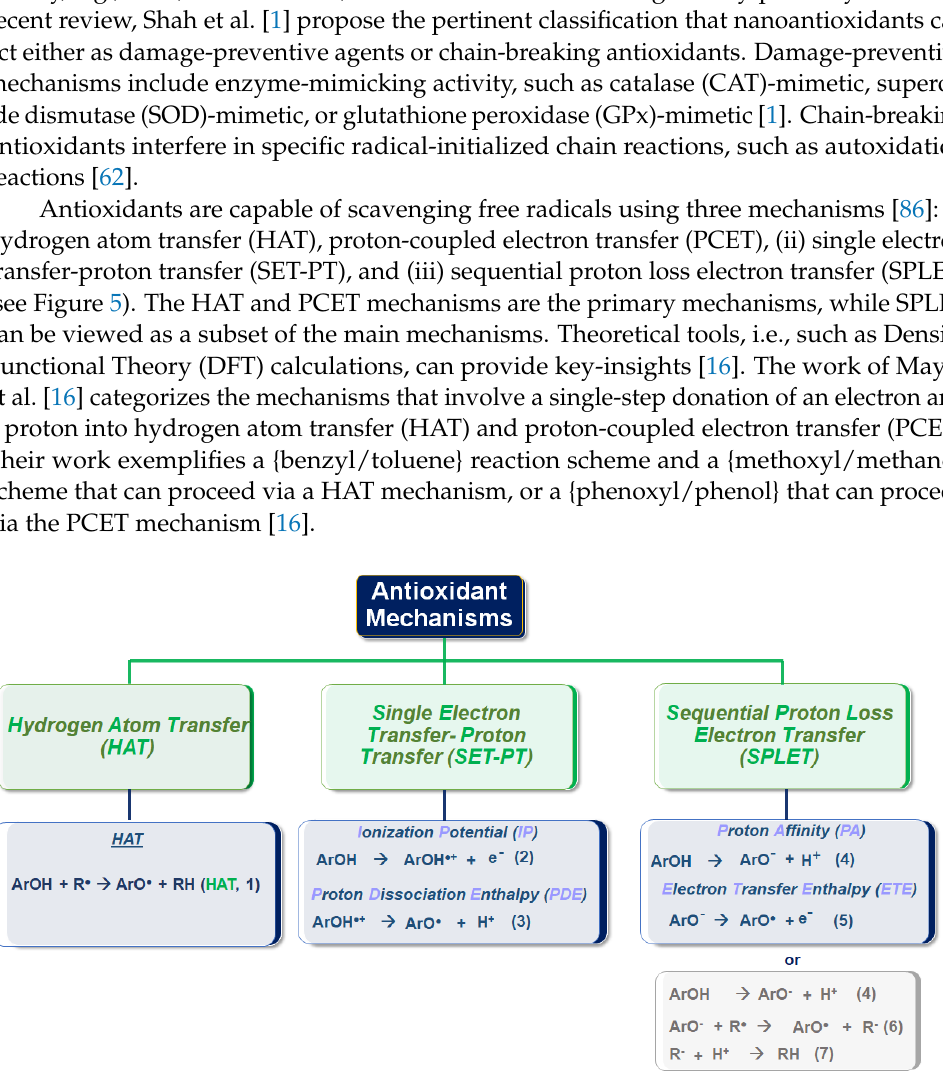
Figure 5. Antioxidant activity can be generally categorized in the three mechanisms depicted above: ( i ) hydrogen atom transfer (HAT), proton-coupled electron transfer (PCET), ( ii ) single electron transfer-proton transfer(SET-PT), and ( iii ) sequential proton loss electron transfer (SPLET).